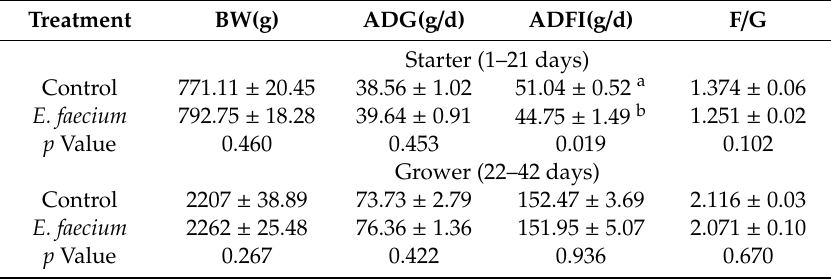
Table 3. Dietary E. faecium supplementation and broiler growth performance.